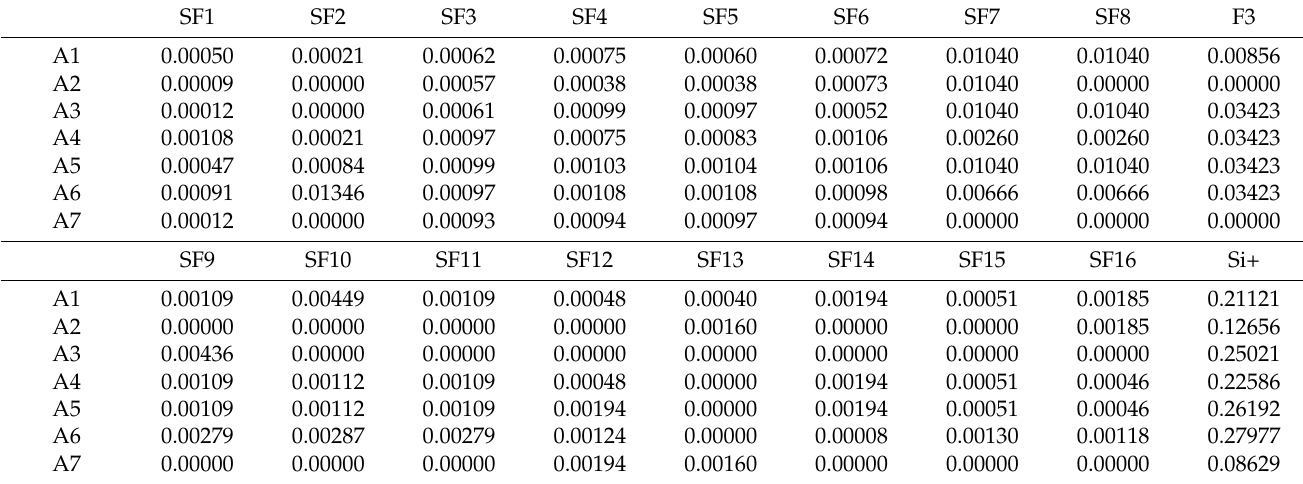
Table A8. Matrix of distances to the ideal solution.